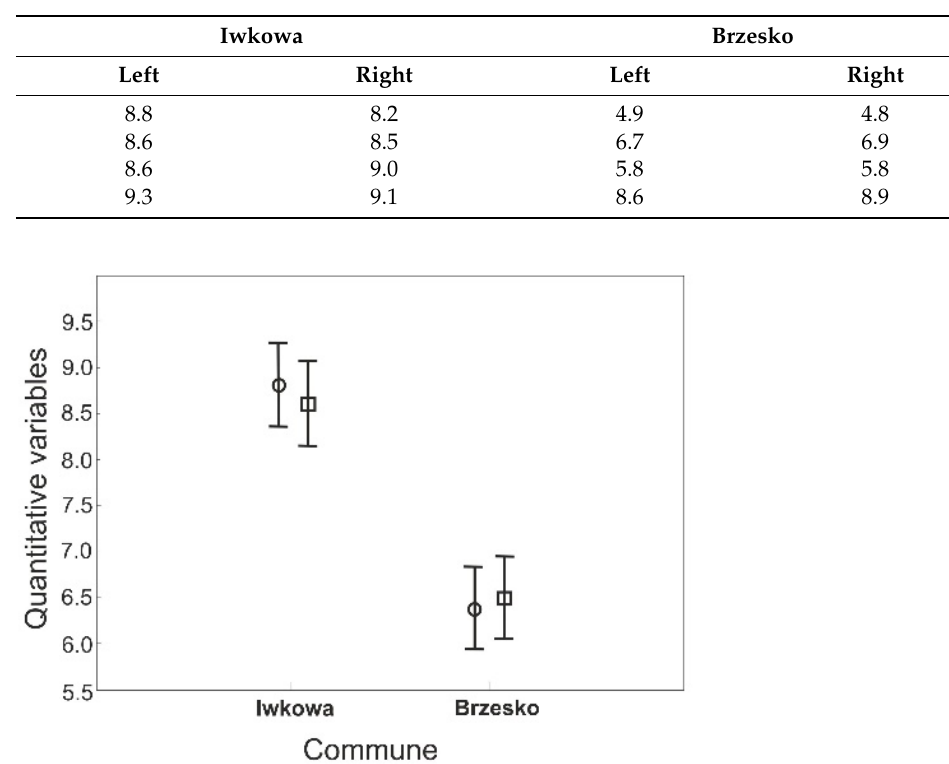
Table 5. Average scores using Wejchert’s impression curve method for the Communes of Iwkowa and Brzesko.